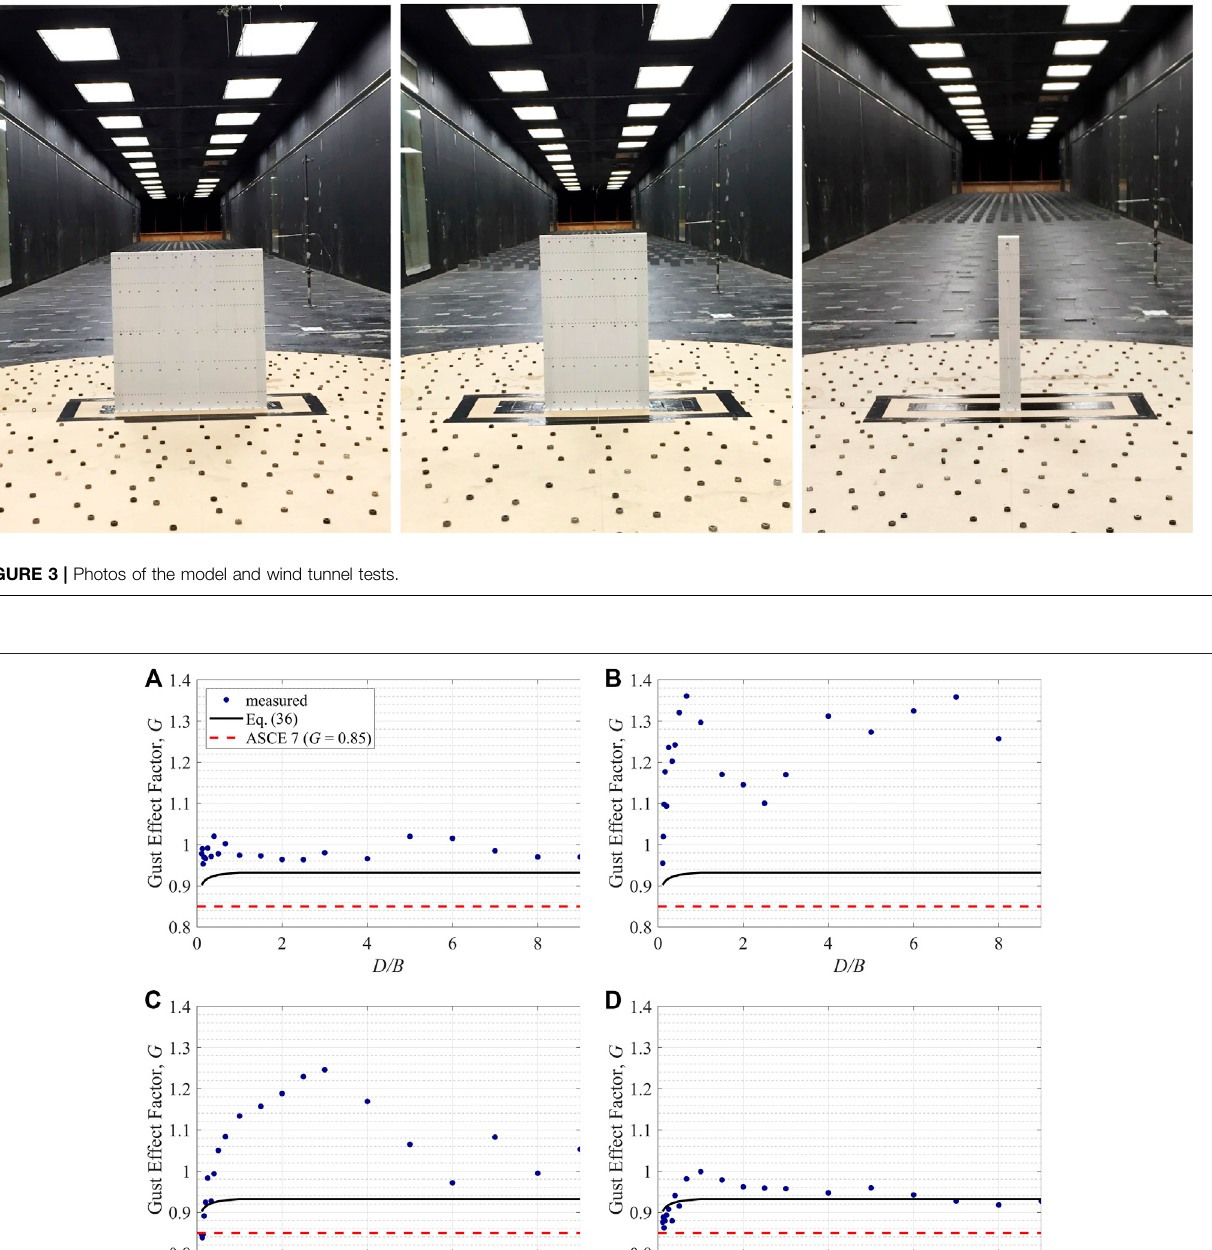
Frontiers in Built Environment |